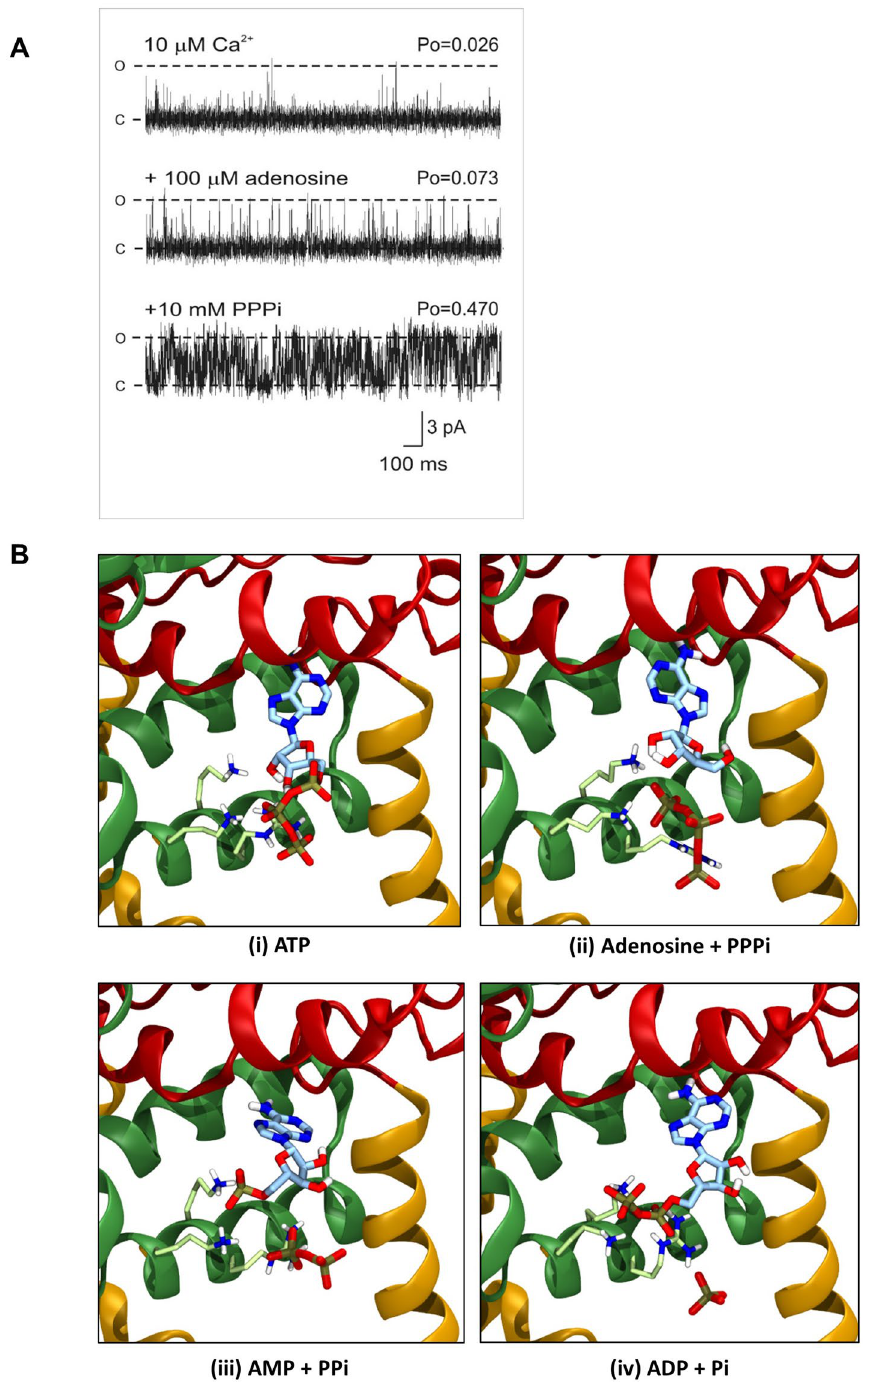
Figure 5. Effects of adenosine plus PPPi on RyR2 gating and the docking of complementary fragments of ATP. ( A ) Current fluctuations through a typical single RyR2 channel recording in the presence of 10 μ M Ca 2 + (top trace), after addition of 100 μ M cytosolic adenosine (middle trace) and the subsequent addition of 10 mM cytosolic PPPi in the continued presence of 100 µ M adenosine (bottom trace). The holding potential was 0 mV. O and C represent the open and closed channel levels, respectively. ( B ) The RyR2 ATP binding site with the most ATP-like docking results for (i) ATP, (ii) adenosine and PPPi, (iii) AMP and PPi, and (iv) ADP and Pi. In each case, the nucleoside ligand was docked first, the most ATP-like pose was adopted as part of the protein, and the phosphate ligand subsequently docked into the same